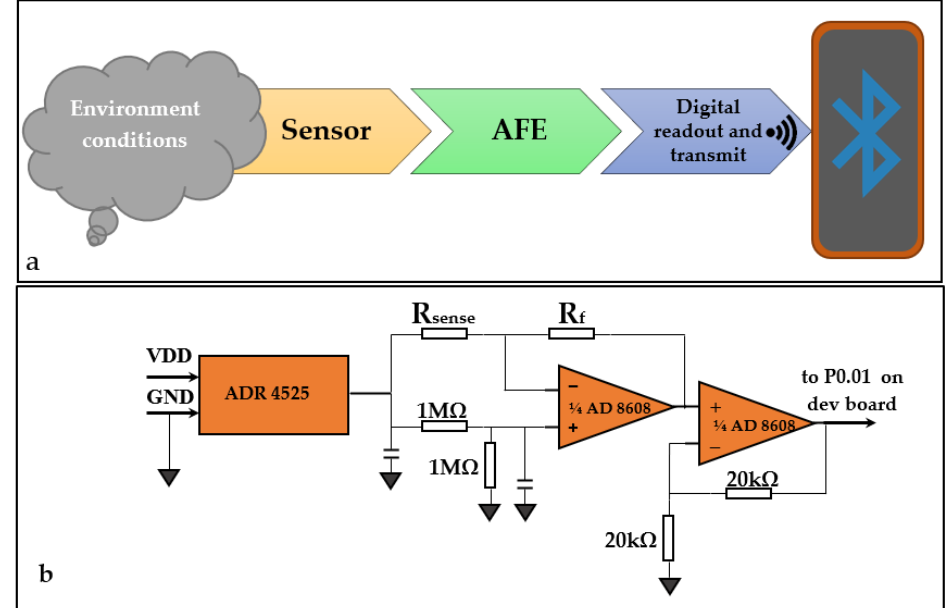
Figure 1. ( a ) Block diagram for the electronic module of the wearable device; ( b ) schematic of the analog front end (AFE).